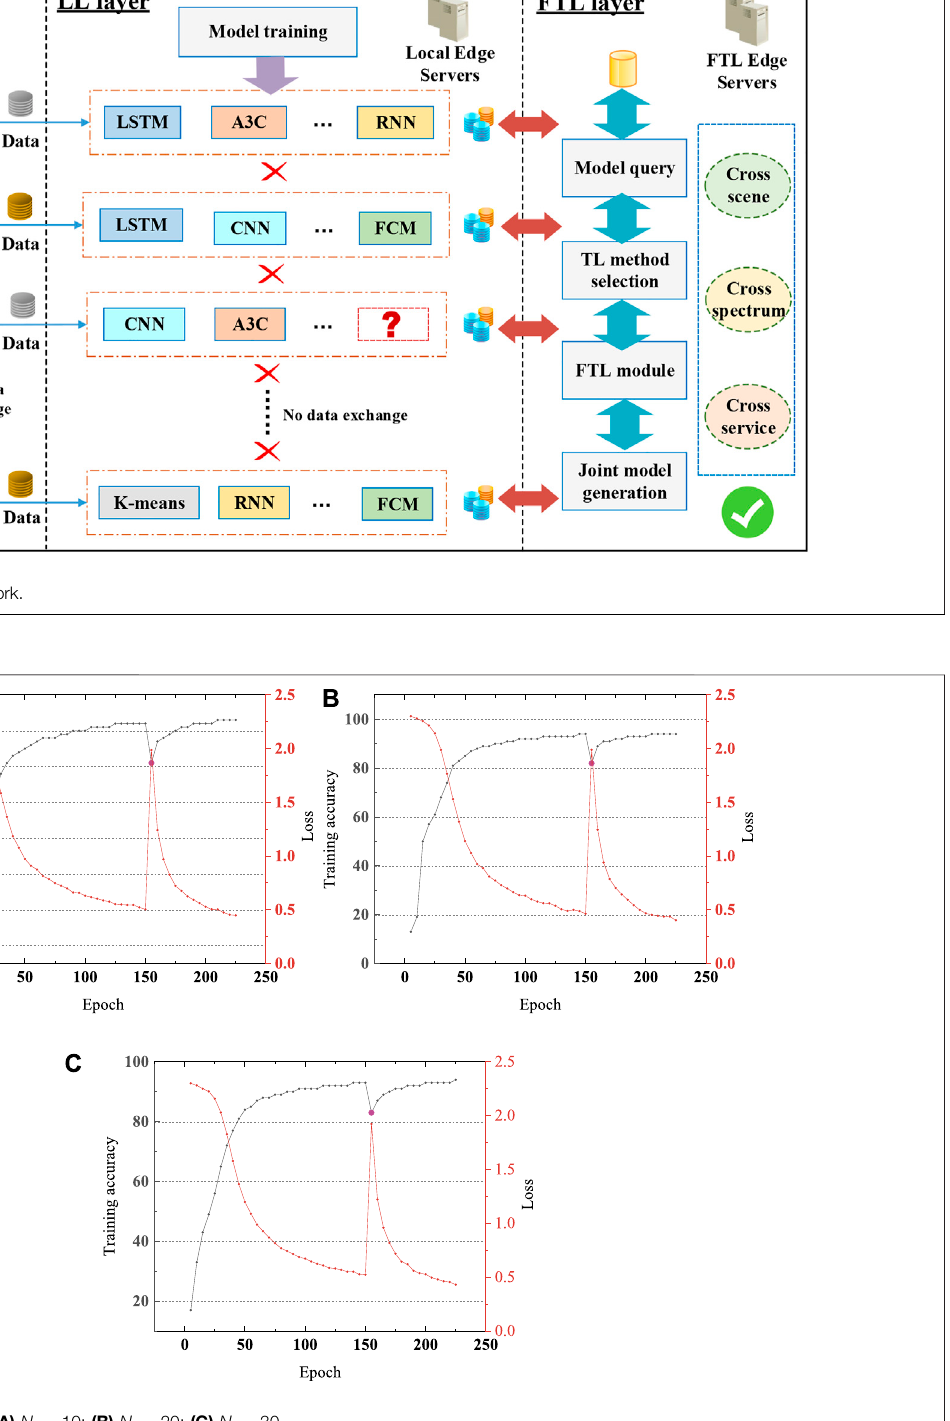
Frontiers in Communications and Networks |